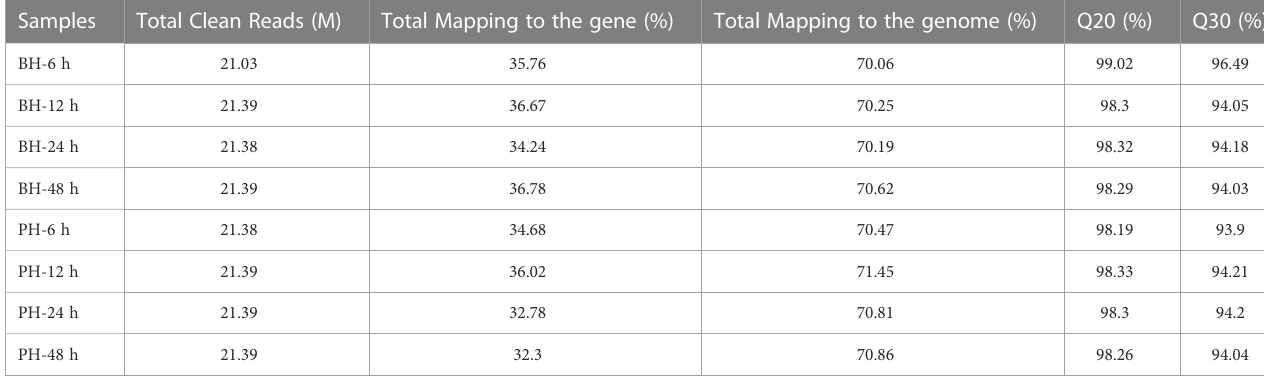
TABLE 1 Transcriptome data statistics.